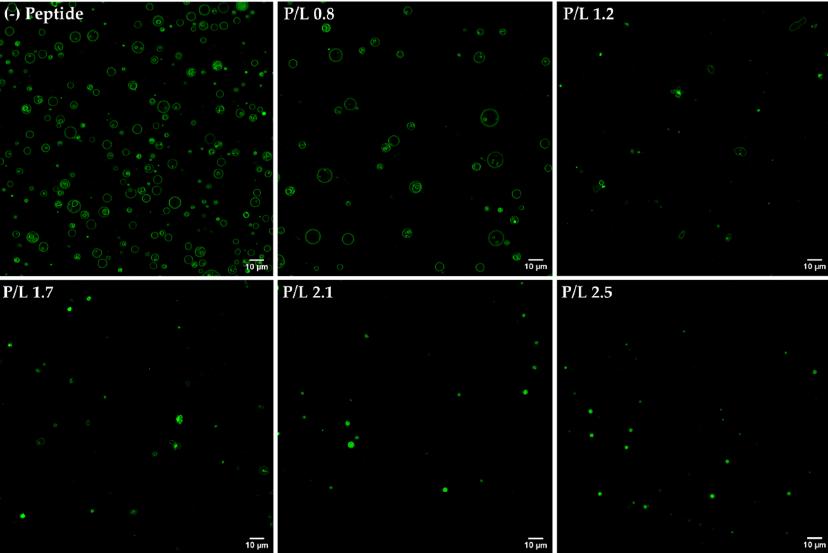
Figure 8. Morphology of the POPC:POPG (1:1) GUVs in the presence of W-BP100 obtained by confocal microscopy. Representative images of 2% NBD-labelled GUVs in the absence ( − ) and presence of peptide (P/L of 0.8, 1.2, 1.7, 2.1, and 2.5) upon 10 min of incubation. GUVs were incubated with HEPES buffer (solvent of the peptide) to exclude any contribution to GUV aggregation (Figure S5). Videos of W-BP100 action on GUVs are provided in the Supplementary Materials (Videos S1–S3). Magnification: 630×. Scale bar: 10 µm.